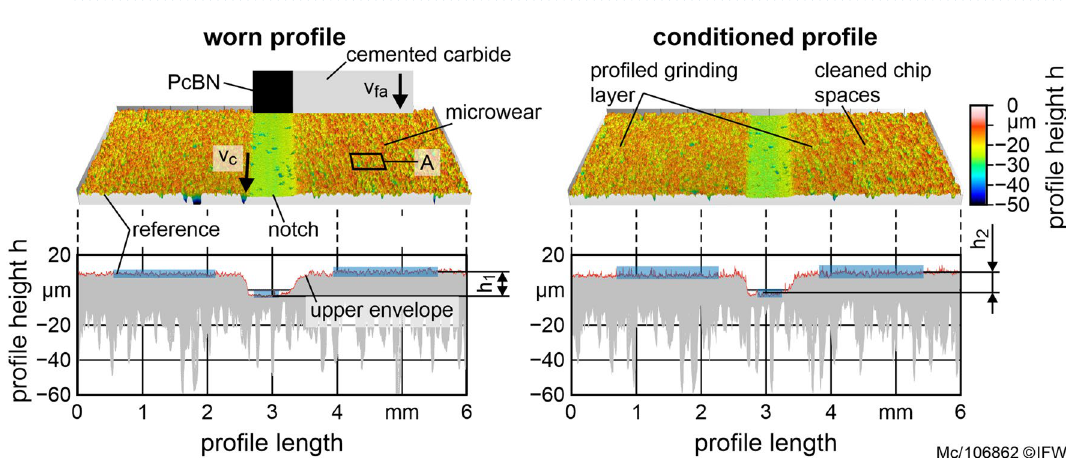
Figure 4. Methodology of measuring the topography and profile of the grinding